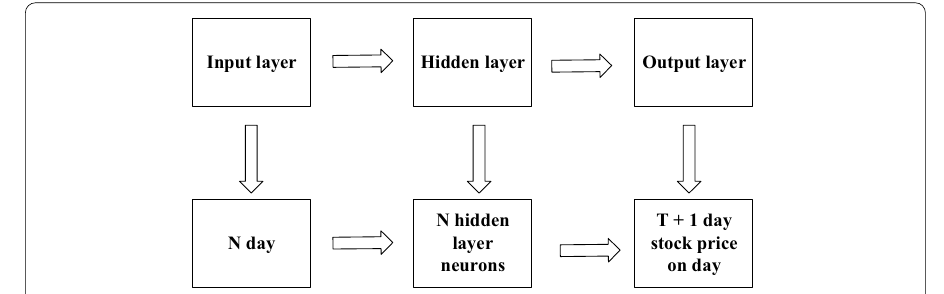
Fig. 1 Schematic diagram of stock market forecast